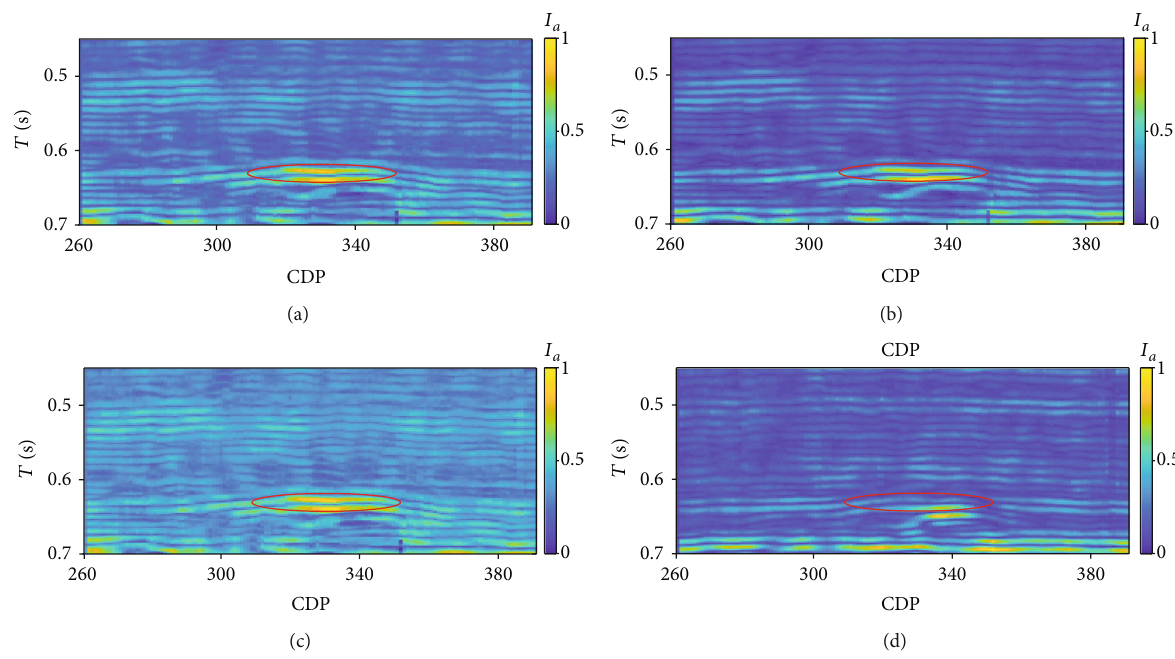
Figure 7: The results of FAVO inversion. I a indicates the dispersion term. (a) is the section of dispersion term of Lamé parameter, (b) is the section of dispersion term of bulk modulus, (c) is the section of dispersion term of Russell fl uid factor, and (d) is the section of dispersion term of P-wave velocity. The red circle highlights the location of the gas reservoir. The dispersion terms are